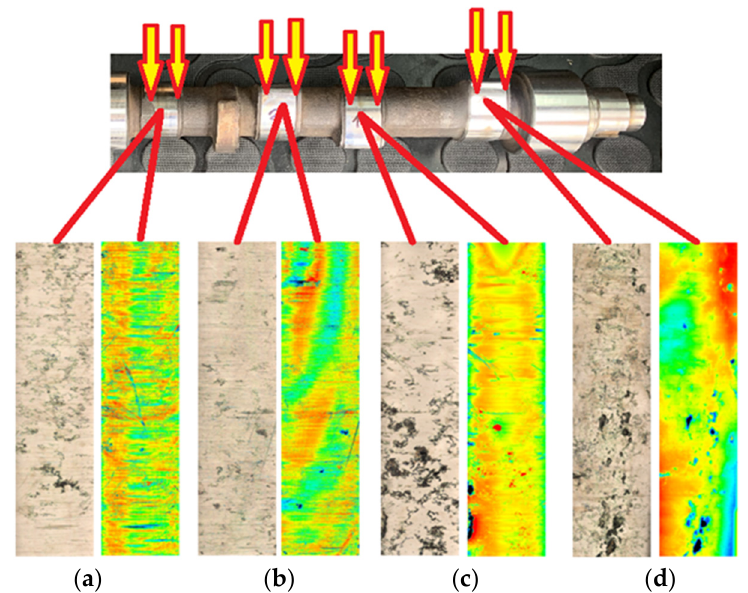
Figure 9. Wear of cam friction surfaces on 3rd and 4th cylinders: ( a ) 3rd cylinder intake cam; ( b ) 3rd cylinder exhaust cam; ( c ) 4th cylinder intake cam; ( d ) 4th cylinder exhaust cam.